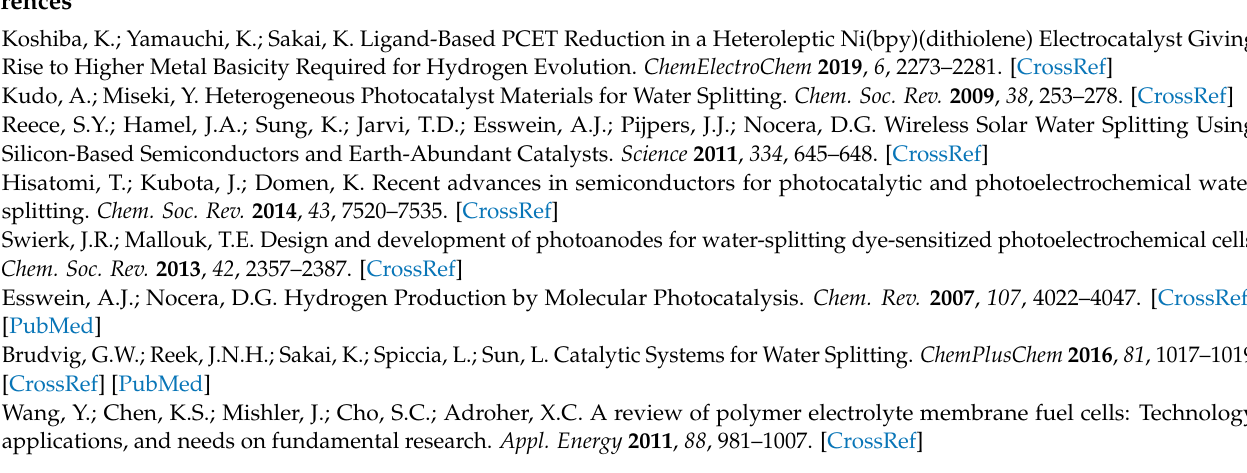
eq. of complex 1 ; Figure S25: Emmision spectra of Fluorescein (0.3 mM) in DMF/H 2 O 1:2 (black) and with the addition of 1–10 eq. of complex 2 ; Figure S26. Cyclic voltammograms of 2 (10 − 3 M) in DMF (black) with the Multiple Cycle scan method and 2 (10 − 3 M) in DMF (red) with the Single Scan method, with 0.1 M n-Bu 4 NPF 6 , a glassy carbon as a working electrode, an Ag/AgCl as a reference electrode and a Pt wire as a counter electrode. The scan rate was 100 mV/s; Table S1: 1 H-NMR